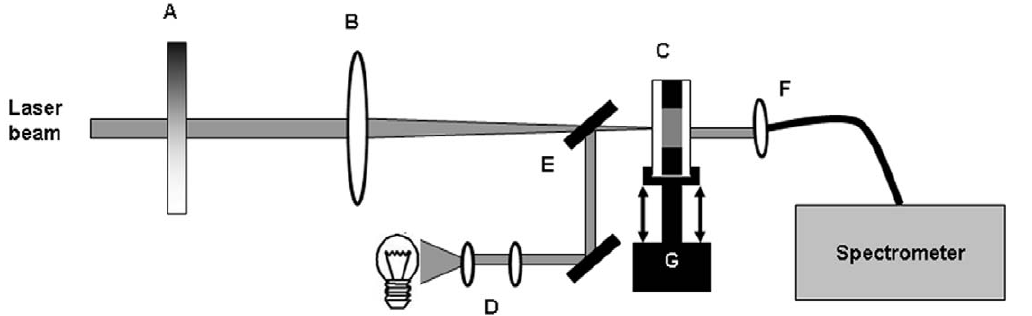
Figure 7. Experimental set-up. Diagram showing the set-up for the experimental laser exposure and transmission study of human lens. Laser intensity was adjusted using a graded neutral density filter (A) and focused using an f=85 mm focusing lens (B) onto the lens sample (C). Spectral transmission of the lens was measured using an incandescent light source, a set of collimating lenses (D), a flip-in mirror (E), and a spectrometer. The lens sample was moved relative to the laser beam using motorized translation stages